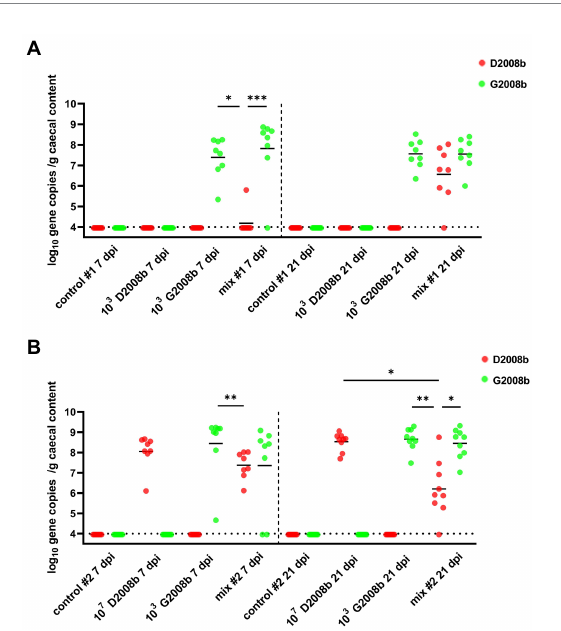
FIGURE 2 Amounts of Campylobacter jejuni strains in cecal content (log 10 gene copies/g of cecal content) from birds at 7 and 21 dpi for room 1 (A) and room 2 (B) . Red and green dots correspond to the amount of D2008b and G2008b, respectively, for individual birds. Horizontal bars represent median values, and horizontal dotted lines denote the detection limit (4 log 10 CFU/g of cecal content). Statistical analyzes were conducted using a Kruskal-Wallis test followed by Dunn’s post-hoc tests with Bonferroni adjustments to compare median values between colonized groups according to the time point and room. *, ** and *** indicate p <0.05, p <0.01 and p <0.001